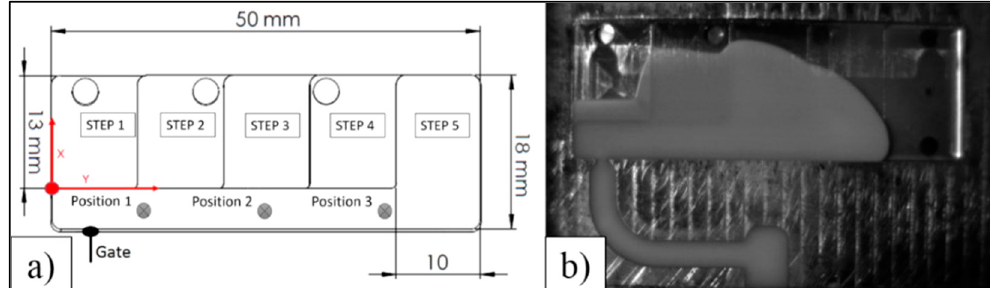
Figure 4. ( a ) Reference system applied in the measurements and the melt positions in the lateral channel considered in the study. These positions are also the final length of the short shots; ( b ) Extracted picture at Position 3 from the video recordings of a complete experiment. Reproduced with permission from